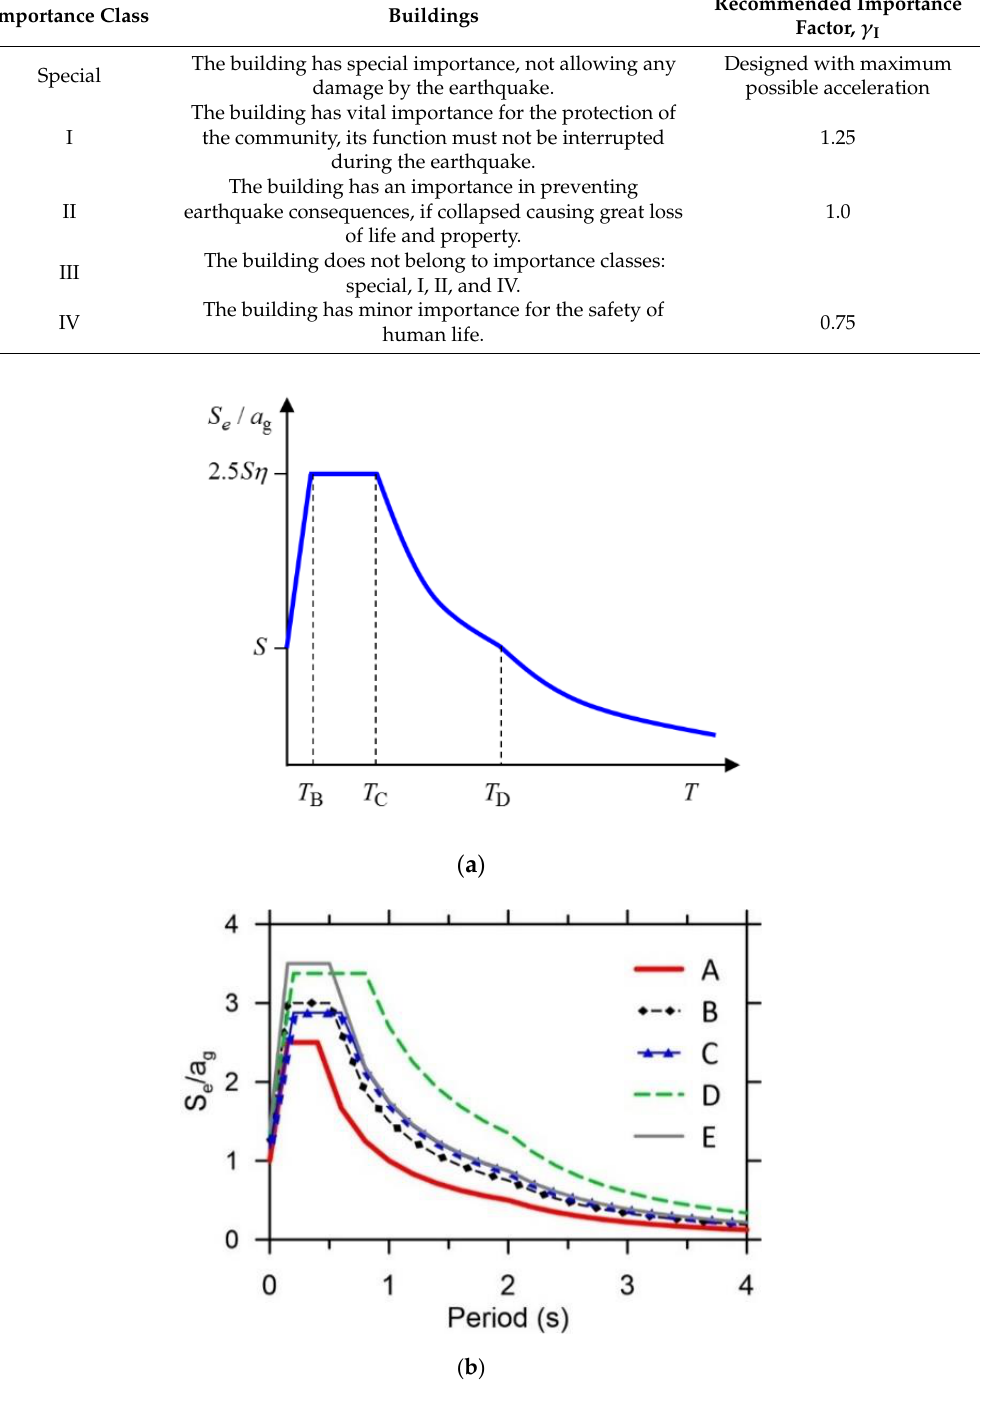
Table 2. Importance class and recommended importance factors values in TCVN 9386: 2012 [14].